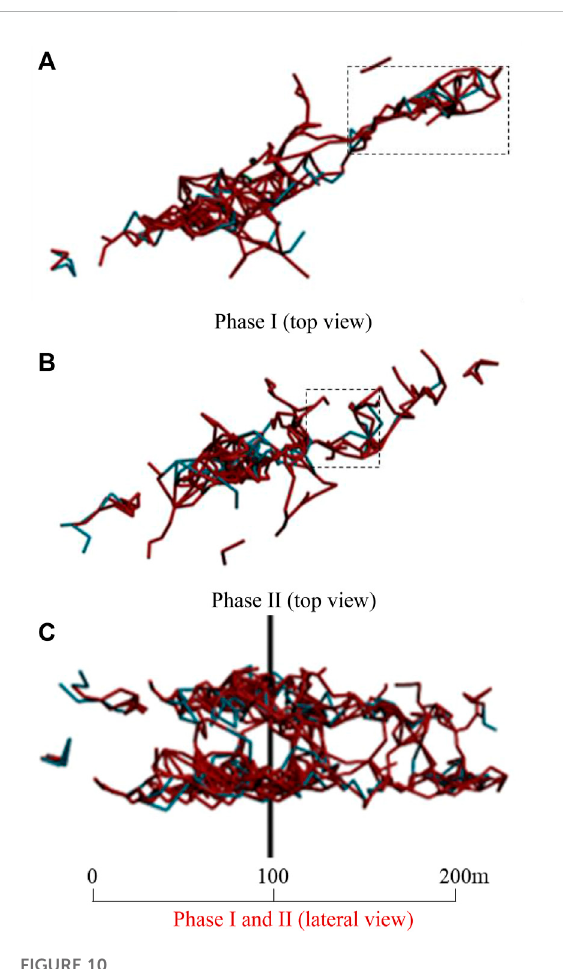
FIGURE 10 Fracture propagation path at different fracturing stages. (A) , Phase I(top view); (B) , Phase II(top view); (C) , Phase I and II (lateral